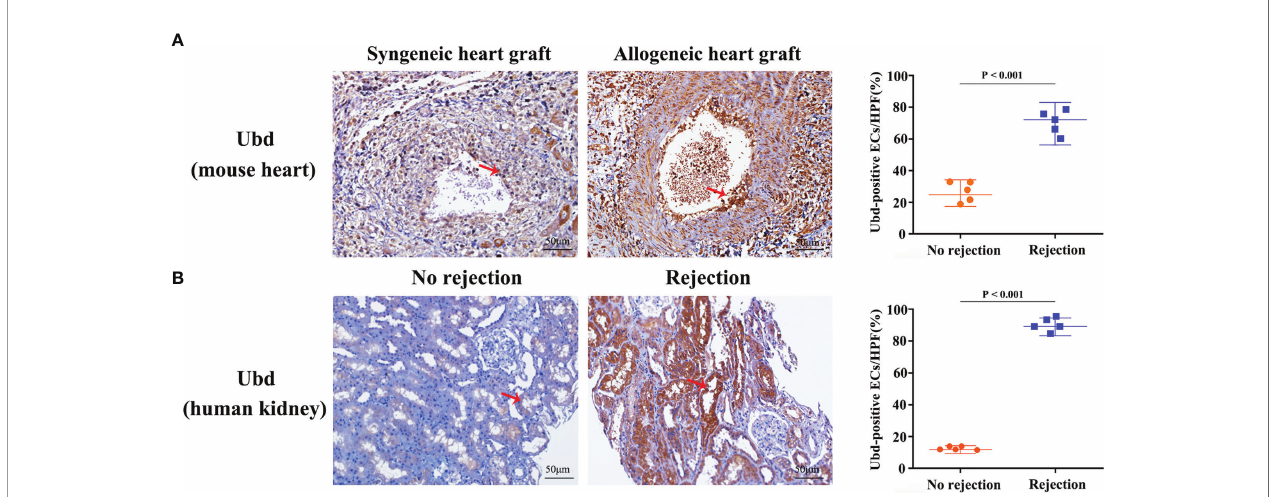
FIGURE 6 | Upregulation of Ubd in endothelial cells during rejection. (A) Representative immunohistochemistry staining of Ubd in the allogeneic and syngeneic mouse heart grafts. (B) Representative immunohistochemistry staining of Ubd in human kidney biopsy specimens with/without rejection. Arrows indicate positive staining in endothelial cells. Scale bars, 50 mm. Quantitative analysis was shown on the right (n=5 for each